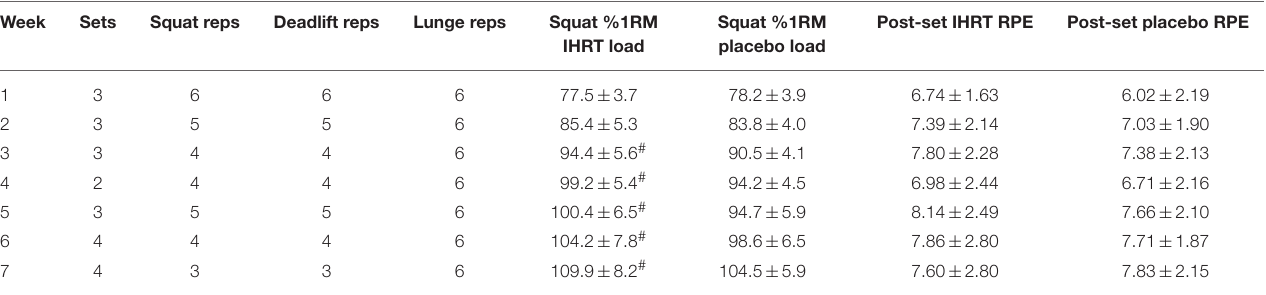
TABLE 1 | Repetitions (Reps) and sets each week for squats, deadlifts, and lunges (3 lunges each leg per set) and percentage 1RM for squat lifted and post-set RPE for each group each week. Week Sets Squat reps Deadlift reps Lunge reps Squat %1RM